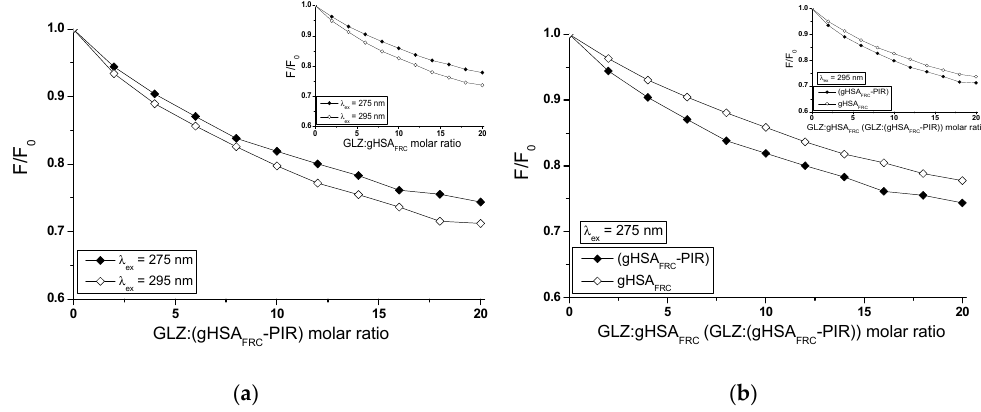
Figure 11. Quenching fluorescence of glycated, both in the presence (gHSA FRC -PIR) and absence of piracetam (gHSA FRC ), human serum albumin complexed with GLZ (4 × 10 − 6 mol ∙ L − 1 –4 × 10 − 5 mol ∙ L − 1 ). The albumins concentration was 2 × 10 − 6 mol ∙ L − 1 ; ( a ) GLZ-(gHSA FRC -PIR) (in the main view) and GLZ-gHSA FRC (in the insert) and ( b ) λ ex = 275 nm (in the main view) and λ ex = 295 nm (in the insert); the error bars are smaller than the symbols.